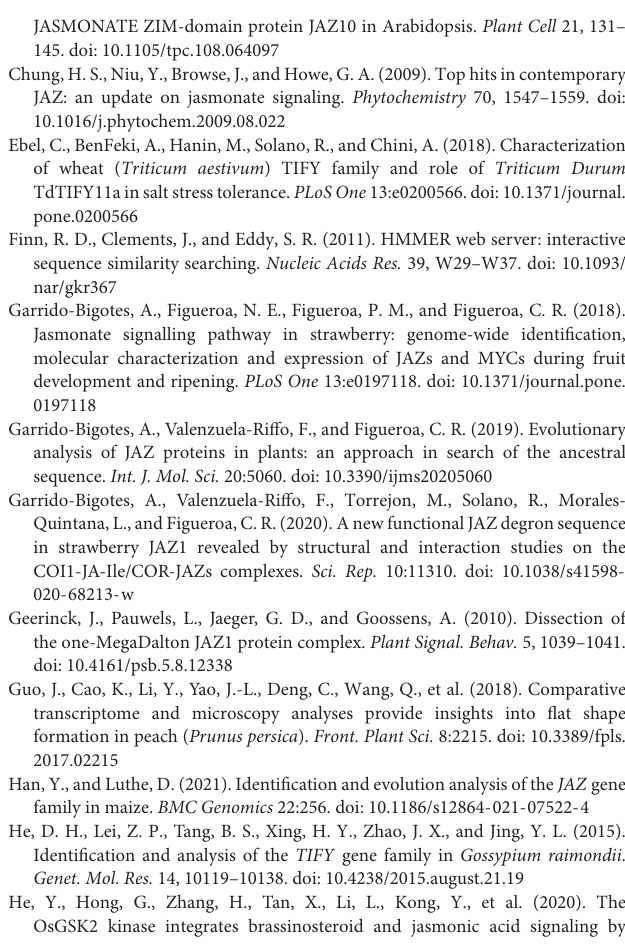
Supplementary Table 7 | Pearson correlation analysis of anthocyanin contents and gene expression levels of TIFY family members under exogenous MeJA treatment. For the genes with extremely low expression levels, this analysis was not applied (NA). Supplementary Data Sheet 1 | Deduced protein sequences alignment of TIFY family genes from various plant